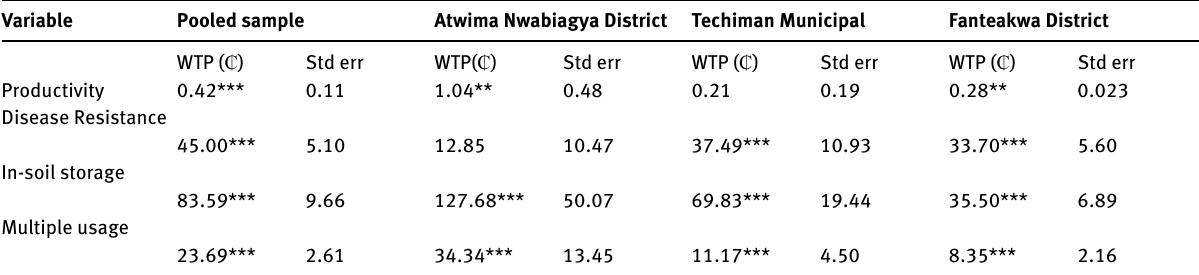
Table 6: WTP estimates for pooled and subsamples Variable Pooled sample